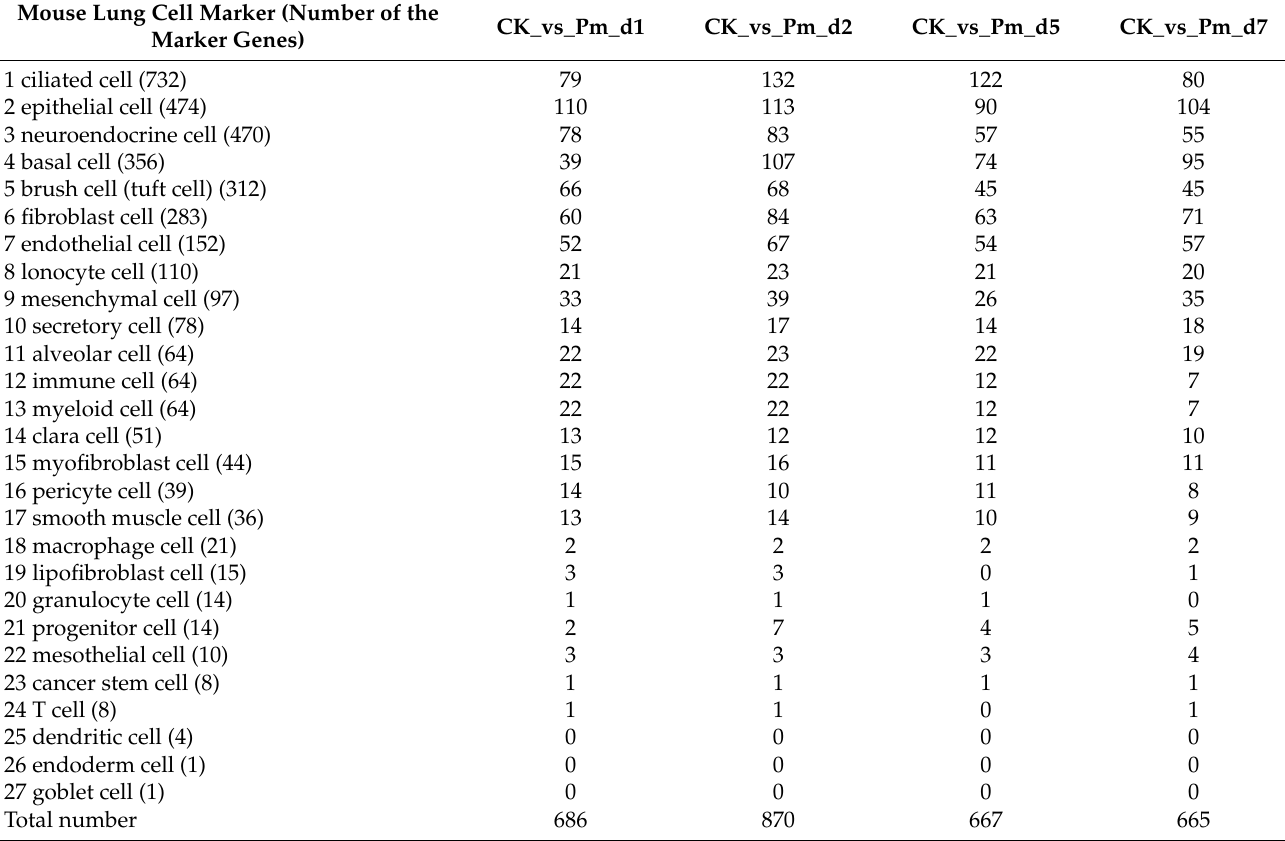
Table A4. The results of DEGs that mapped to the mouse lung cell marker